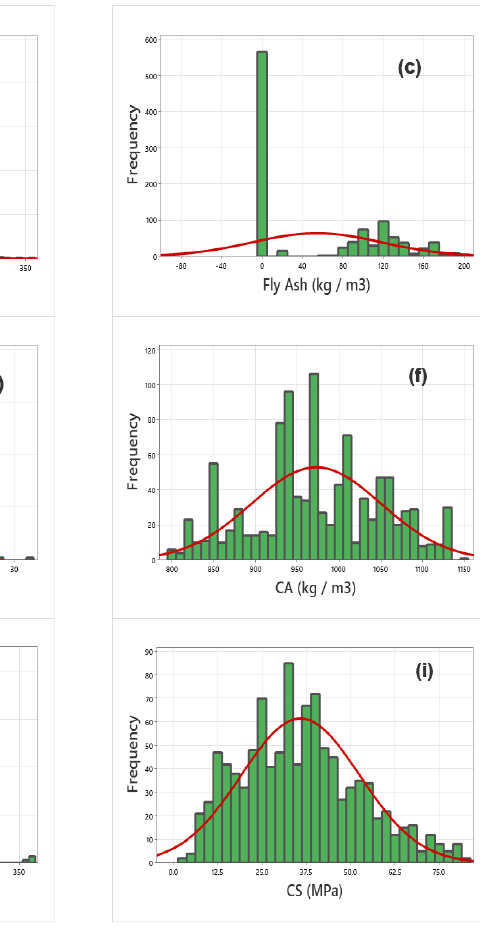
8 of 19 Table 1. Descriptive Statistical Analysis of the Dataset. Variable